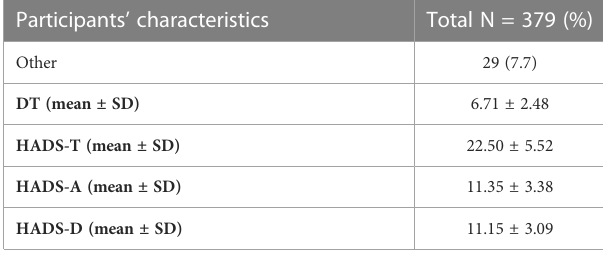
TABLE 1 Demographic and clinical characteristics of the study subjects